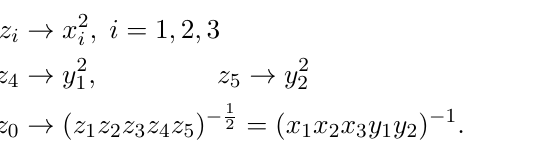
Figure 22 . fP (3), P (2) g quiver with SU(2) 3 (cid:2) D 3 , global symmetry, b = 1, dim M H [1 3 ] [1 2 ] Perform the mapping according to (3.6), (3.7) and